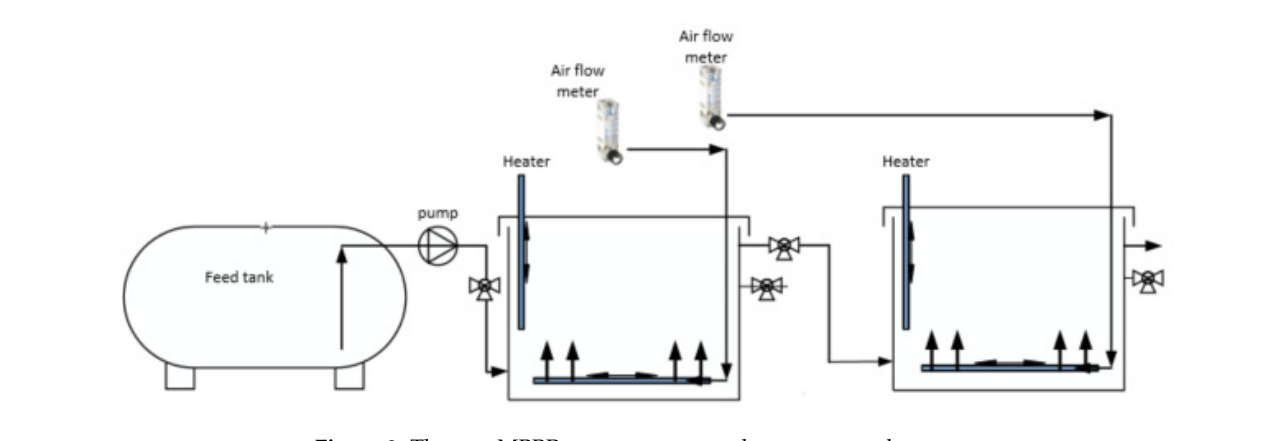
Figure 2. The two MBBR reactors setup at the treatment plant. Table 1. The operating parameters used in the experiment in both